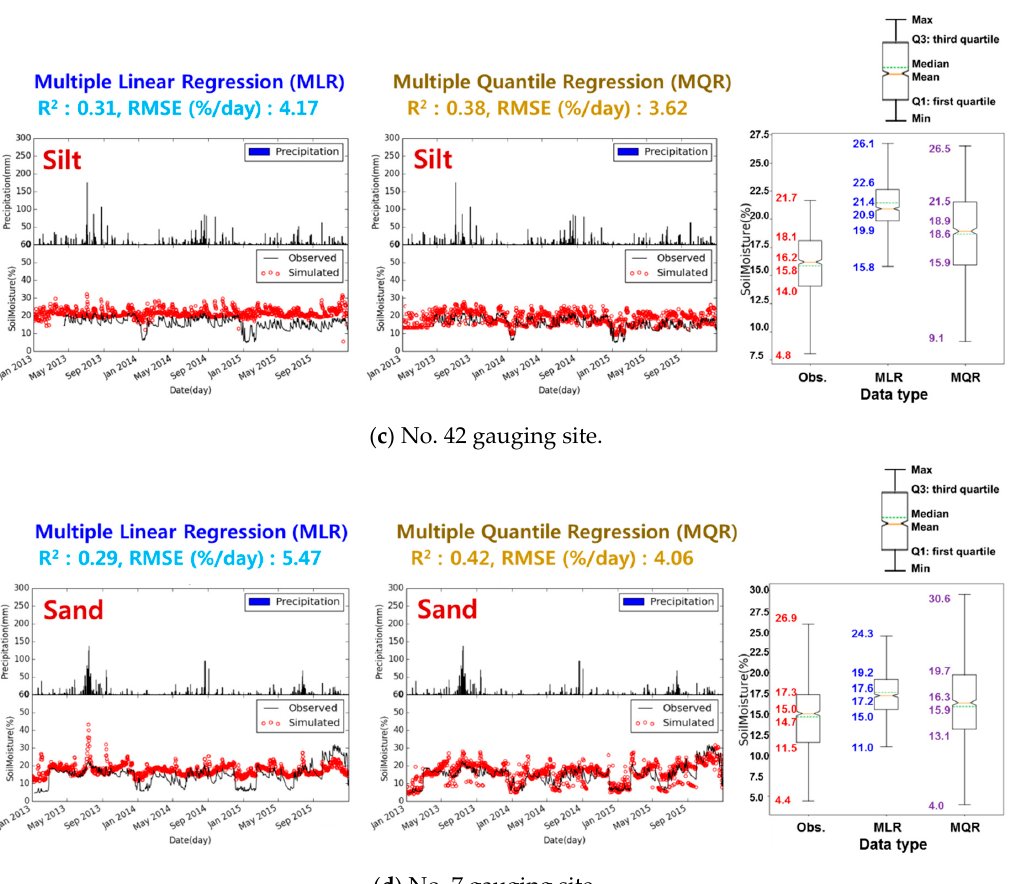
Figure 5. Comparison graphs of observed SM and estimated SM for each soil type between multiple linear regression (MLR) and quantile regression (MQR). Additionally, the box plots are illustrated.